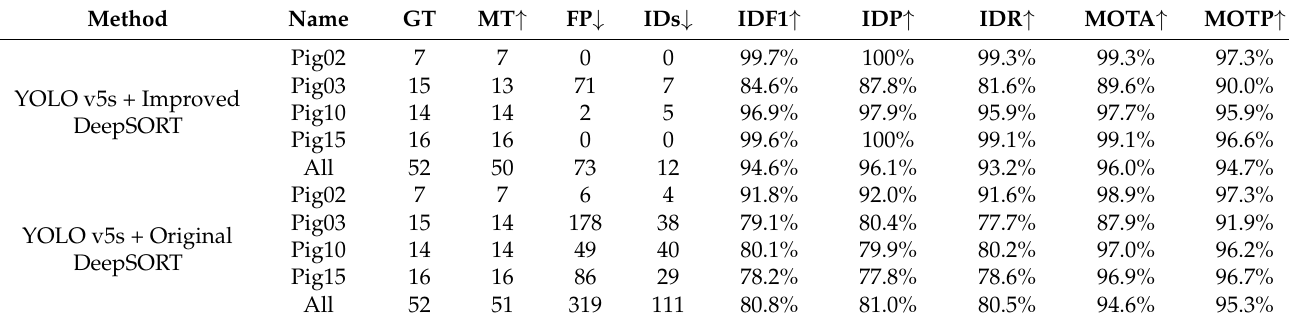
Table 4. Tracking results of improved and original DeepSORT based on YOLO v5s.